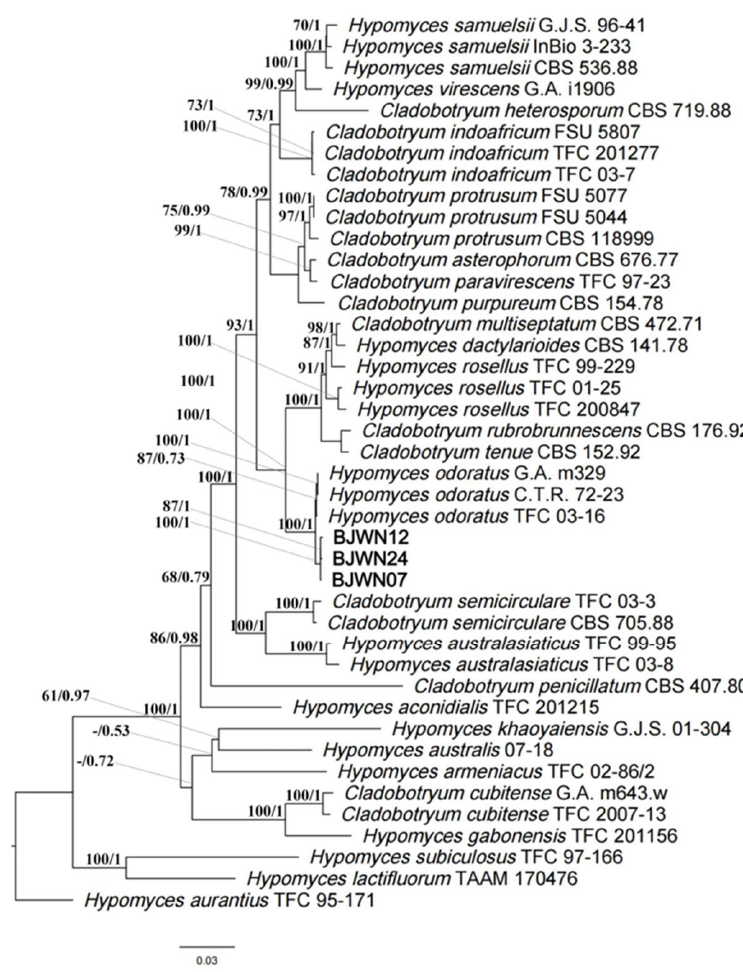
Figure 3. Phylogenetic tree based on rDNA ITS regions and partial sequences of TEF1 and RPB2 genes sequences for our three strains and selected reference isolates retrieved from GenBank of Hypomyces / Cladobotryum . Maximum likelihood (ML) values > 50% and Bayesian inference (BI) values > 0.50 are shown next to topological nodes and separated by “/”. Bootstrap values < 50% and BI values < 0.50 are labeled with “ ‐ ”. H. aurantius was used as an outgroup. Newly generated sequences are indicated in bold.